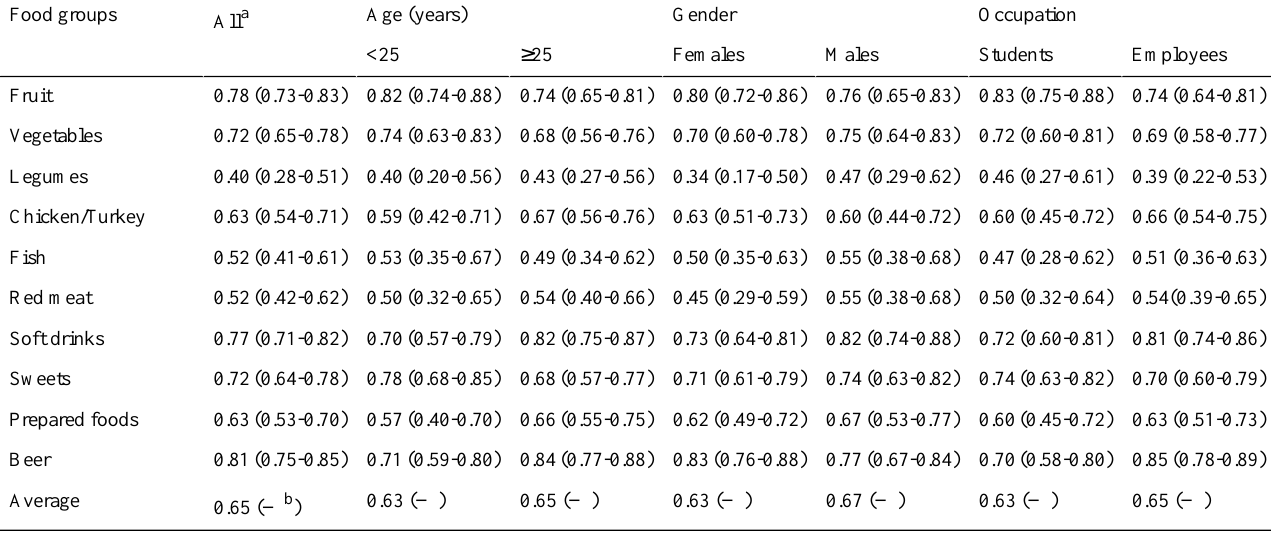
Table 8. Spearman correlation coefficients derived from the electronic 12-hour dietary recall app versus the 4 dietary records for categories of food group consumption and strata: age (years): <25 and ≥ 25; gender: females and males; and occupation: students and employees. Comparison of the electronic 12-hour dietary recall app versus dietary records. Spearman correlation coefficients (95%